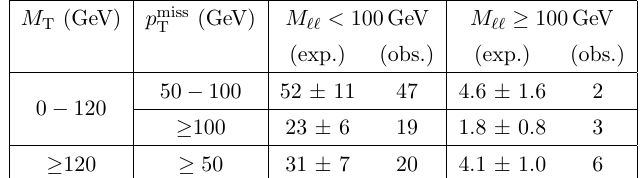
Table 13 . Category B: expected and observed yields in events with three e or (cid:22) that do not form an OSSF pair. For each bin, the (cid:12)rst number corresponds to the expected yield (exp.) and its uncertainty, and the second denotes the observed yield (obs.). The uncertainty denotes the total uncertainty in the yield.